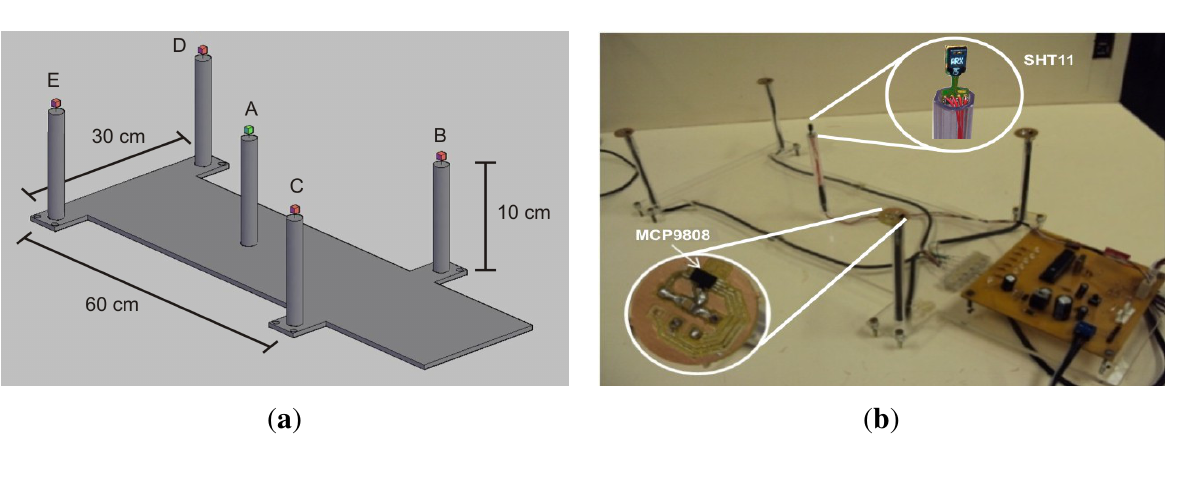
Figure 5. ( a ) Representation of the data acquisition system base; ( b ) experimental setup of the data acquisition system base.